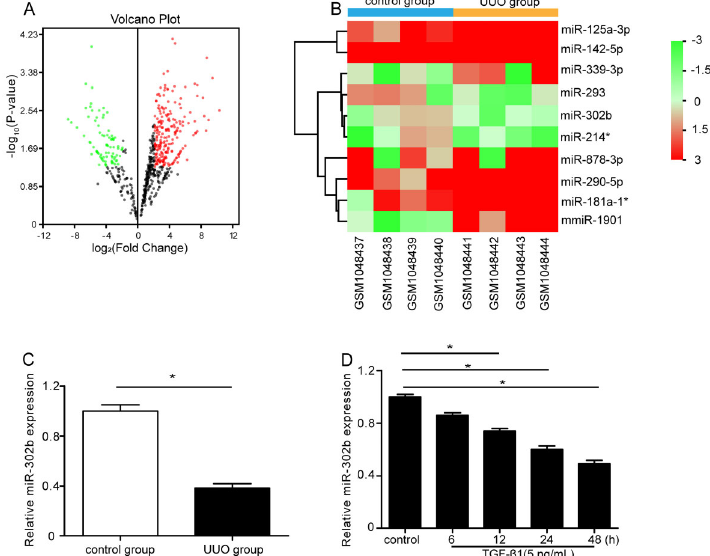
Figure 1. miR-302b was down-regulated in unilateral ureteral obstruction (UUO) mice and transforming growth factor b 1 (TGF- b 1)- treated HK-2 cells. A , Volcano plot of the differentially expressed miRNAs in gene expression pro fi le datasets GSE42716. miRNAs that were not differentially expressed between the UUO group and the control group are represented as black dots. The red and green dots indicate up-regulated and down-regulated miRNAs, respectively. B , miR-302b displayed low expression in the UUO group based on microarray data (GSE42716) analysis. The abscissa and ordinate indicate sample number and differentially expressed miRNAs. miR-214* indicates miR-214-5p and miR-181a-1* indicates miR-181a-1-3p, according to miRbase website. Each square represents an expression value of sample. Red color indicates high expression and green color, low expression. C , miR-302b expression was measured by qRT-PCR (n=6). D , HK-2 cells were treated with saline or TGF- b 1 (5 ng/mL) for 6, 12, 24, and 48 h. miR-302b expression was detected by qRT-PCR. Data are reported as means ± SE (n=3). *P o 0.05 (Student ’ s t -test or